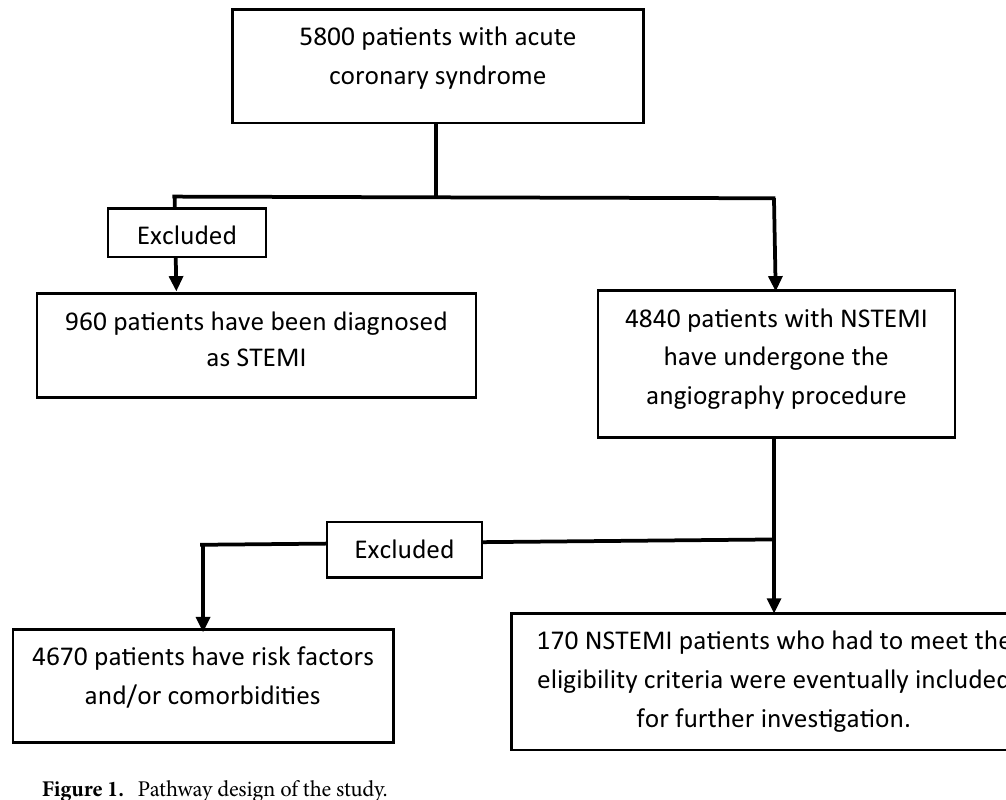
Figure 1. Pathway design of the